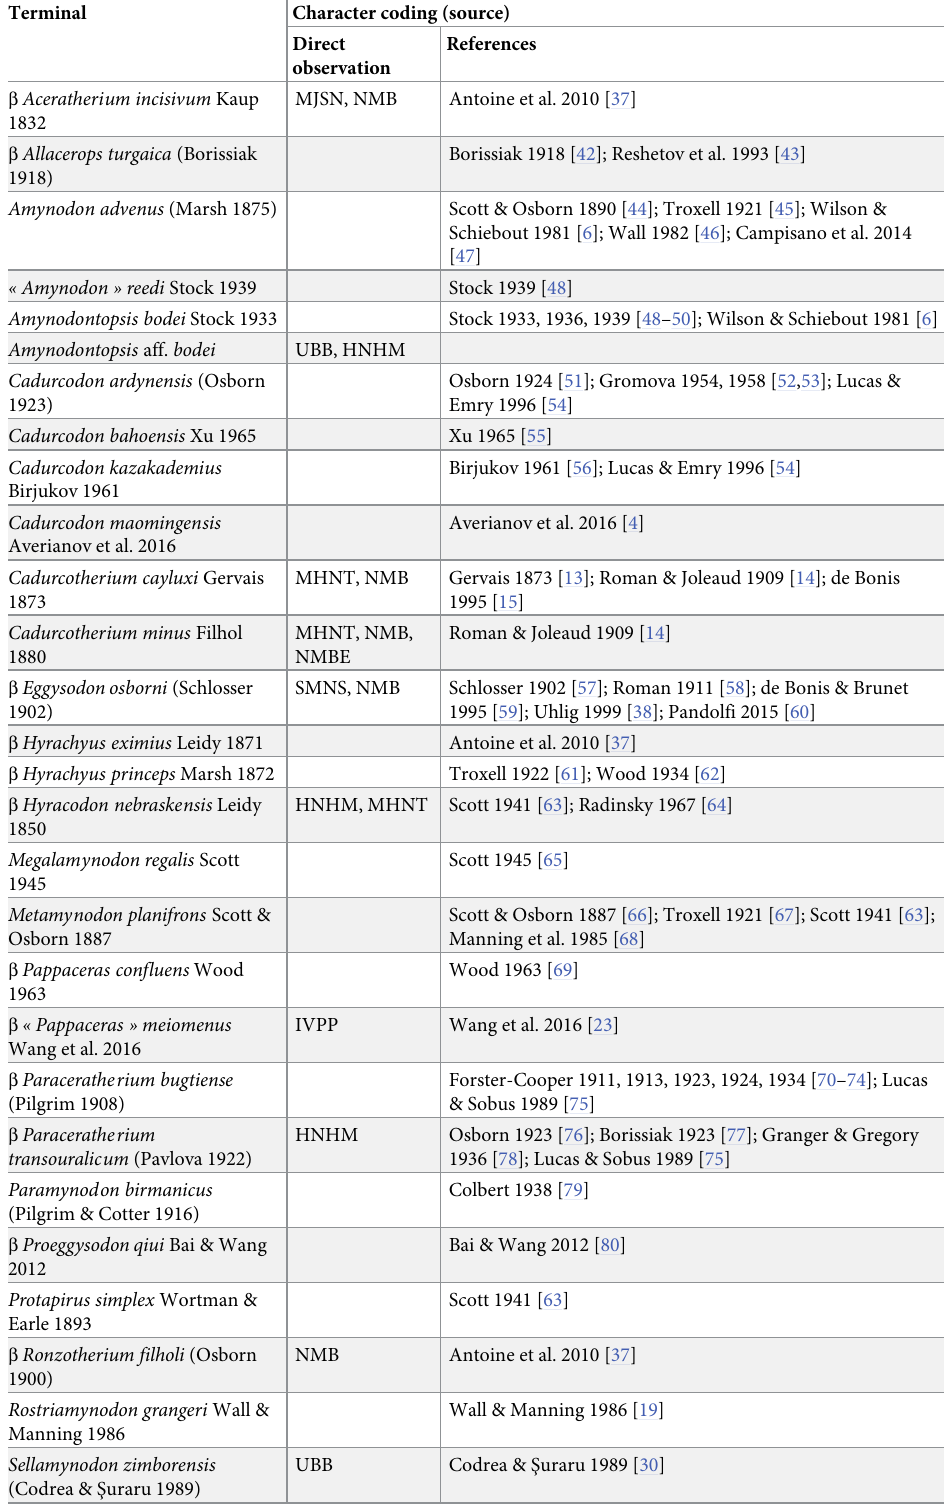
Table 1. List of taxa included in the phylogenetic analysis and their coding